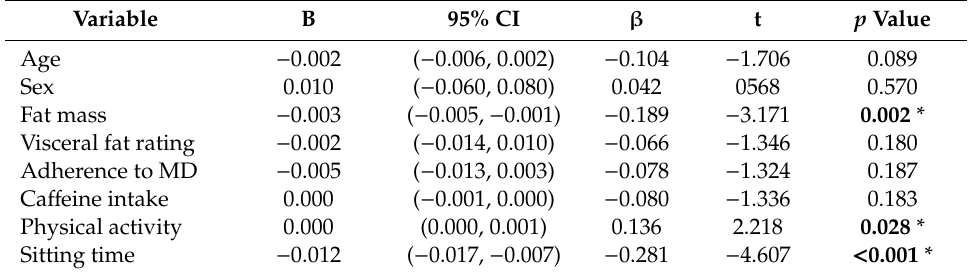
Table 7. Multiple linear regression for IL-10.